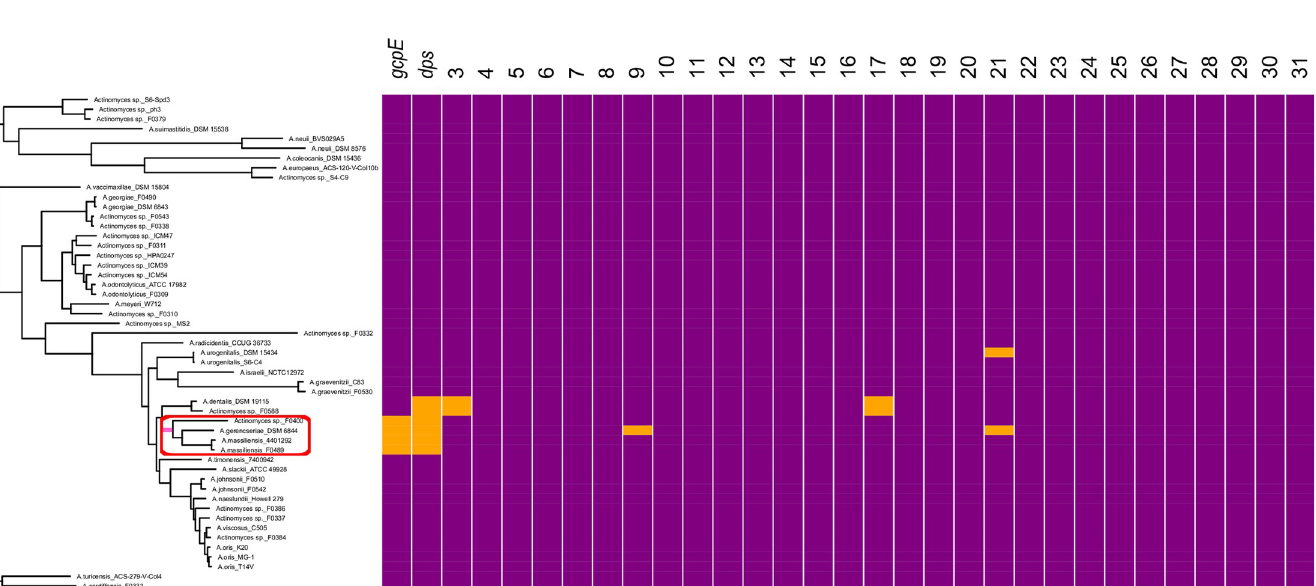
PLOS ONE | https://doi.org/10.1371/journal.pone.0241676 November30,